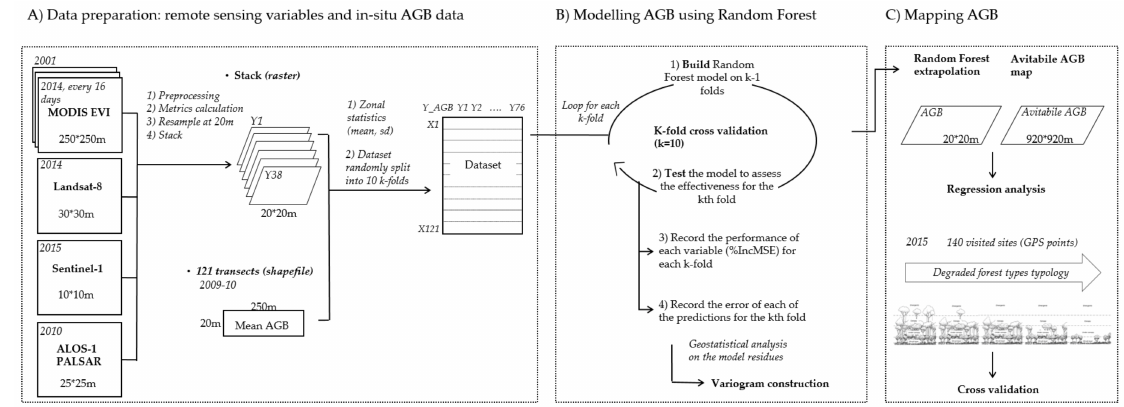
Figure 2. Workflow of the evaluation of the indicators performance in AGB modelling and